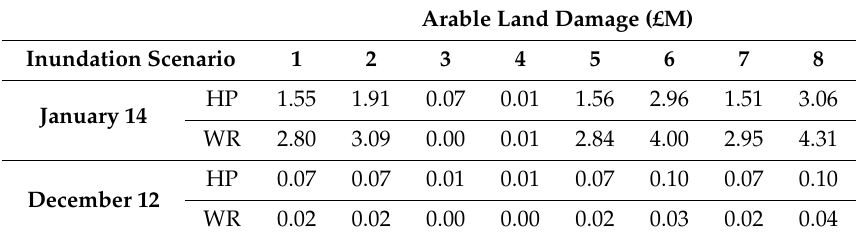
Table 4. Simulated Economic Cost of Inundation for Arable Land Cover.